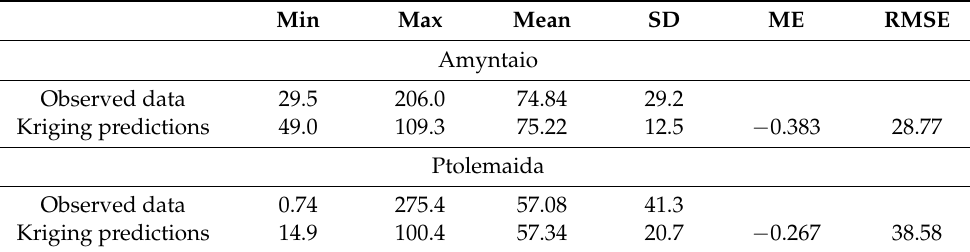
Table 2. Residual statistics of cross-validation results using the leaving-one-out procedure for AGB.